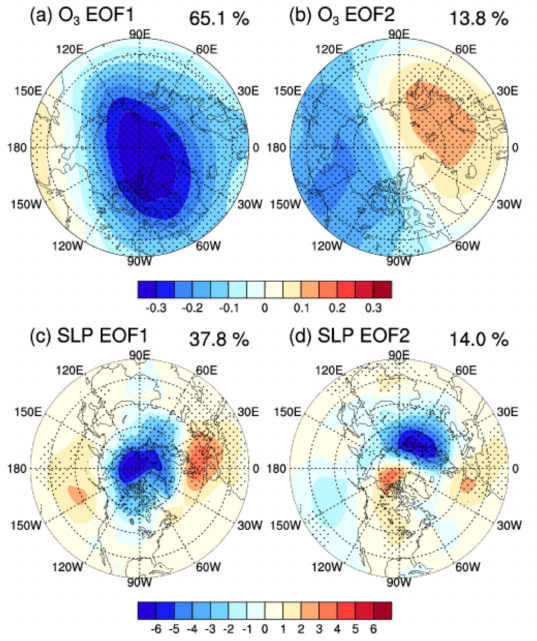
Figure 2. ( a , b ) Regression maps of the ozone concentration (colored shading; unit: ppmm) averaged from 30 to 300 hPa over 55-90 ◦ N upon the normalized first principal component (PC1) and second principal component (PC2) of ozone concentration averaged from 30 to 300 hPa over 55–90 ◦ N in January during 1980-2019. ( c , d ) same as ( a , b ), but for the SLP over 20–90 ◦ N (colored shading; unit: hPa). The values at the top-right corner are the explained variances. The values over the stippled regions are statistically significant at the 95% confidence